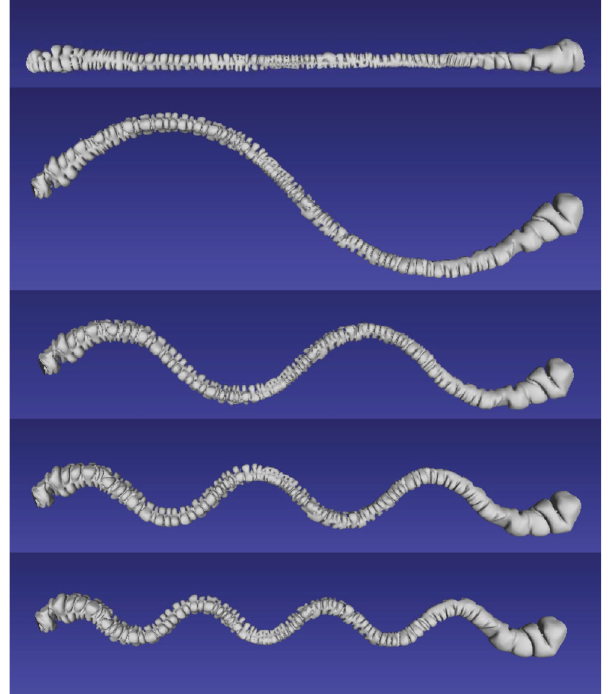
Fig. 12 The centerline of a colon mesh following sine curves of different frequencies. Fig. 13. The orienta-tions of the new frames on the target curve are parameterized. In these examples the target curve is of the same length as the ctl modified .